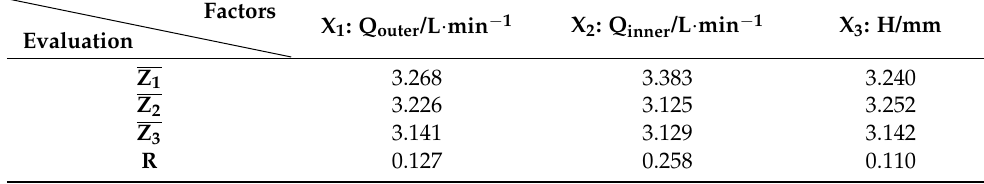
Table 4. Evaluation indices of the orthogonal experiment design (oxygen).